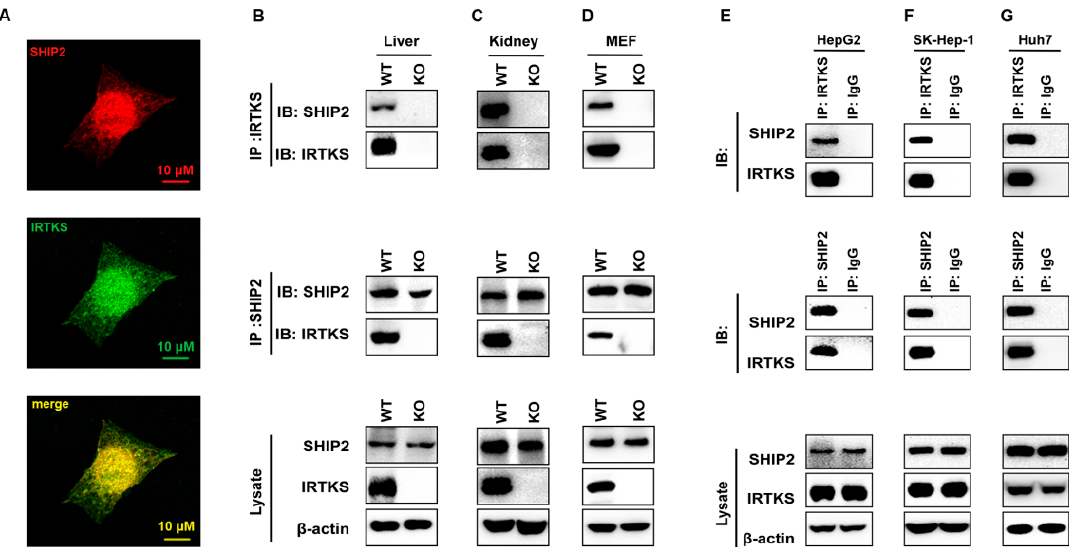
Figure 1. Insulin receptor tyrosine kinase substrate (IRTKS) interacts with Src homology (SH2) containing inositol polyphosphate 5-phosphatase-2 (SHIP2) in vivo. ( A ) Co-localization of IRTKS and SHIP2. HepG2 cells were immunostained with anti-IRTKS antibody (1:50) and anti-SHIP2 antibody (1:50) followed by Alexa-488 conjugated anti-rabbit antibody (1:1000) and Alexa-647 conjugated anti-mouse antibody (1:1000), respectively. Images were taken with a confocal microscope (Nikon & A1Si). ( B – G ) The interaction between IRTKS and SHIP2 was detected by co-immunoprecipitation (co-IP) with anti-IRTKS and anti-SHIP2 antibodies in liver, kidney, and mouse embryonic fibroblasts (MEFs) from wild-type (WT) and IRTKS-knockout (KO) mice, as well as in HepG2, SK-Hep-1, and Huh7 cells. The Immunoglobulin G (IgG) group was the negative control.